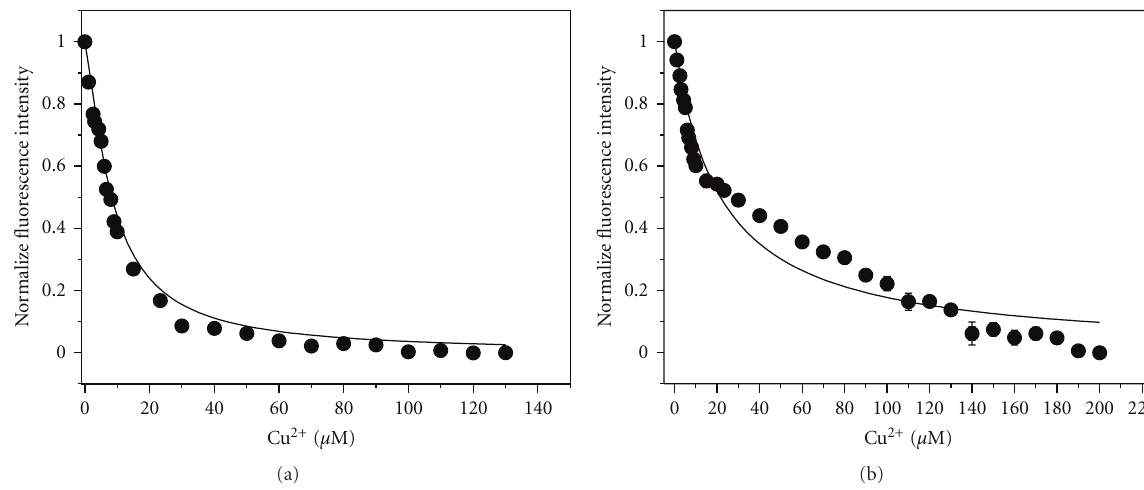
Figure 4: The binding a ffi nity of Cu 2+ to A β 40 peptide in (a) 5% TFE and (b) 40% TFE measured by tyrosine fluorescence spectroscopy. Insets in (a) and (b) show the Jot plot. The concentration of A β 40 was 10 μ M. The solid lines represent the fitting curve using the equation as depicted in Section 2 with n = 1. The R 2 values in (a) and (b) are all > 0.96, and the χ 2 values are < 0.05.